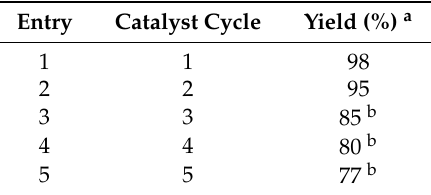
Table 6. Catalyst reuse. Effect on product yields (%). Reaction conditions: 4-toluidine (1